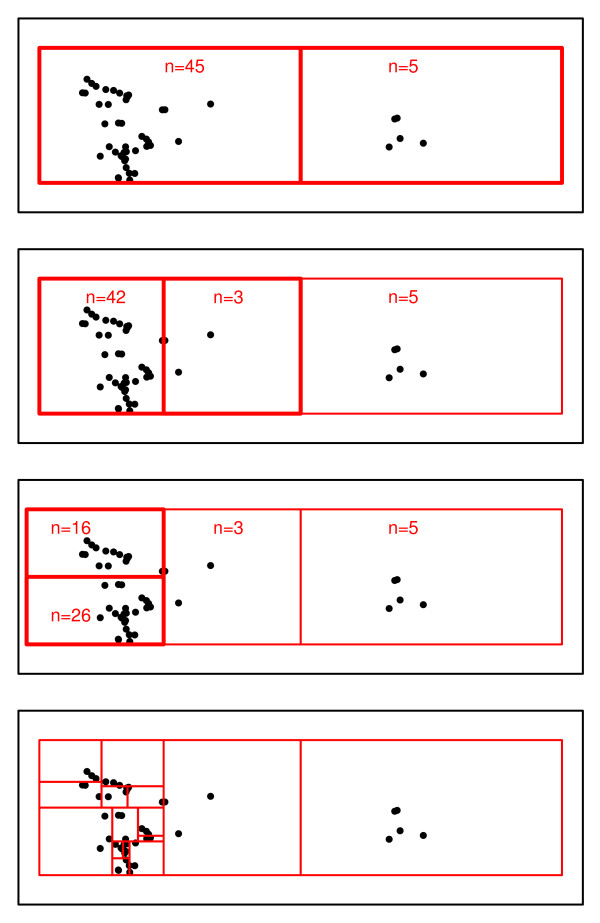
A simplified illustration of the Epiunit NHalf areal unit partitioning algorithm with nmax = 5. From the top, for a study population of 50 in a rectangular study area, Step 1, a rectangle is drawn around the study area and the first partition bisects the longer axis. Step 2, any unit that contains more than nmax = 5 locations is bisected on its longer axis. If all units created have at least 3 (> 2.5, or one-half of nmax = 5) locations, assess whether either unit contains more than 5 locations. Step 3, bisect the longer axis of any unit containing more than 5 units. Step 4, if a unit has less than 2.5 locations go back and make a partition into two units such that the location count is approximately equal. Repeat steps 3 and 4 recursively until all units have between 3 and 5 locations.